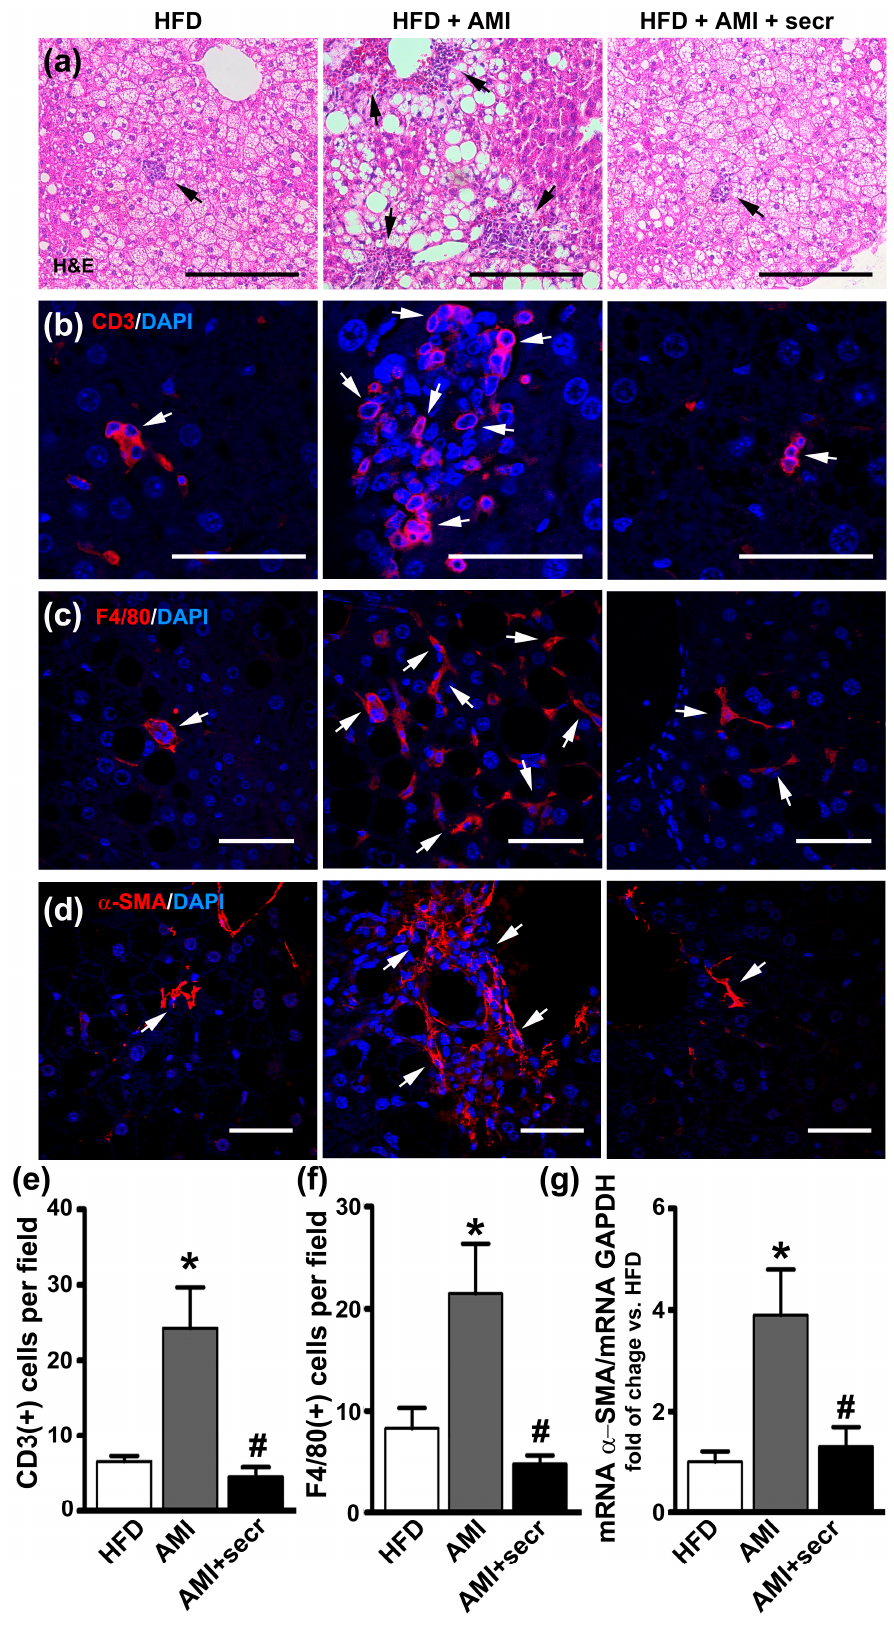
Figure 7. MSC secretome administration prevented hepatic injury induced by AMI in an obese mouse model. Male mice were fed a high-fat diet (HFD) for 34 weeks and divided into three groups. During the last four weeks, one group did not receive additional treatment (HFD group), while a